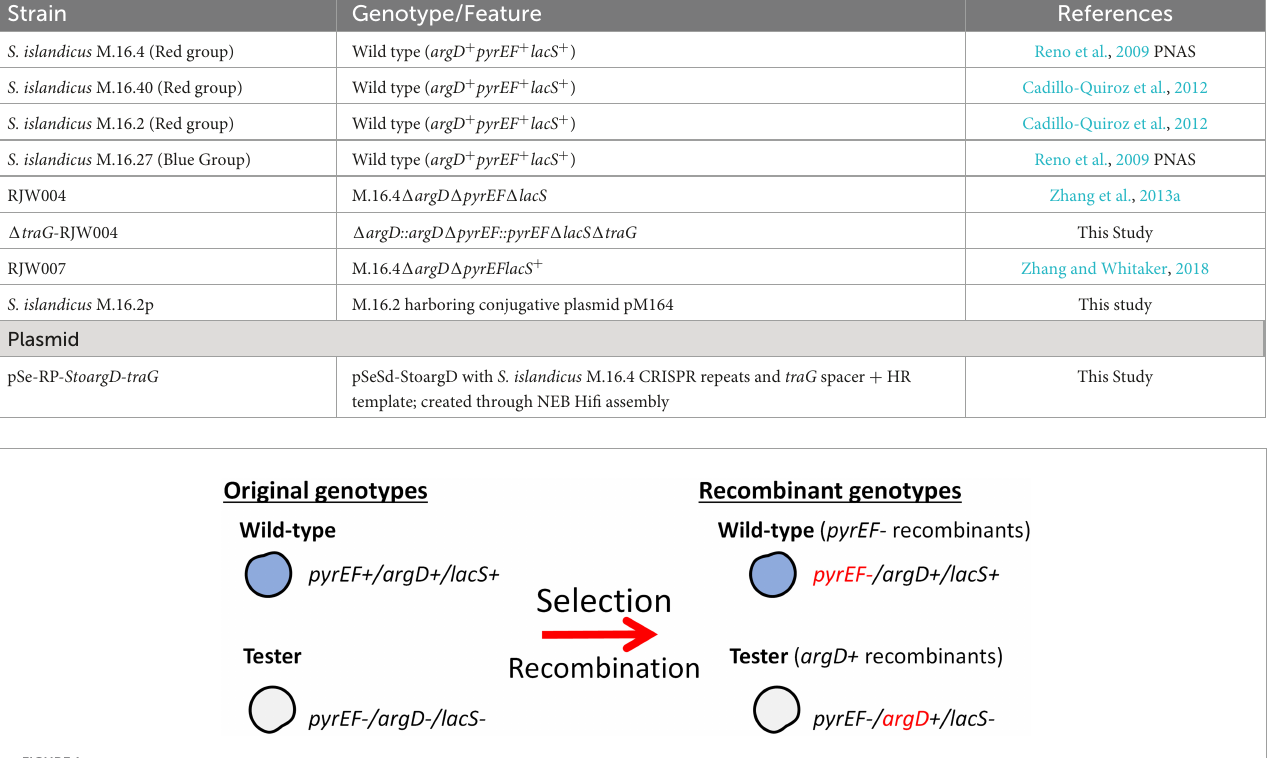
FIGURE1 Selection of argD + pyrEF - recombinant genotypes. This schematic shows necessary genotypes utilized in the mating assays and the recombinants produced through selection. Selection is based on agmatine prototrophy and resistance to 5-FOA.